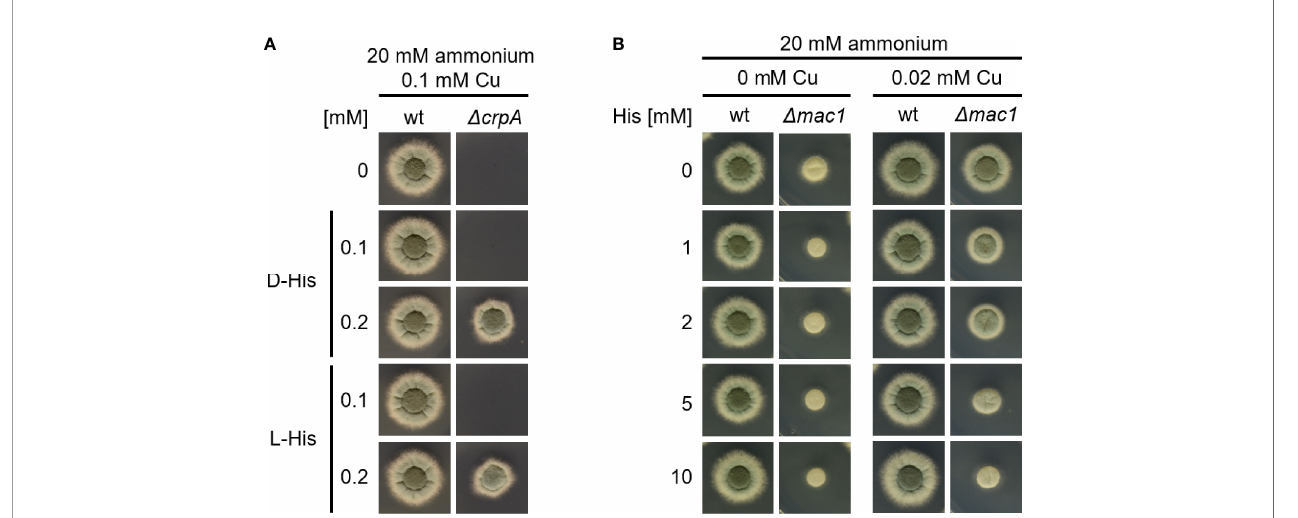
FIGURE 5 | L-His and D-His show a similar protection of A. fumigatus D crpA against Cu toxicity (A) , and His supplementation impedes Cu uptake by A. fumigatus D mac1. (B) A. fumigatus wt and mutant conidia were point-inoculated on AMM plates with 20 mM ammonium as nitrogen source. (A) The growth medium contained 0.1 mM Cu and was supplemented with different concentrations of either L-His (left) or D-His (right). (B) The growth media contained different concentrations of Cu and His,